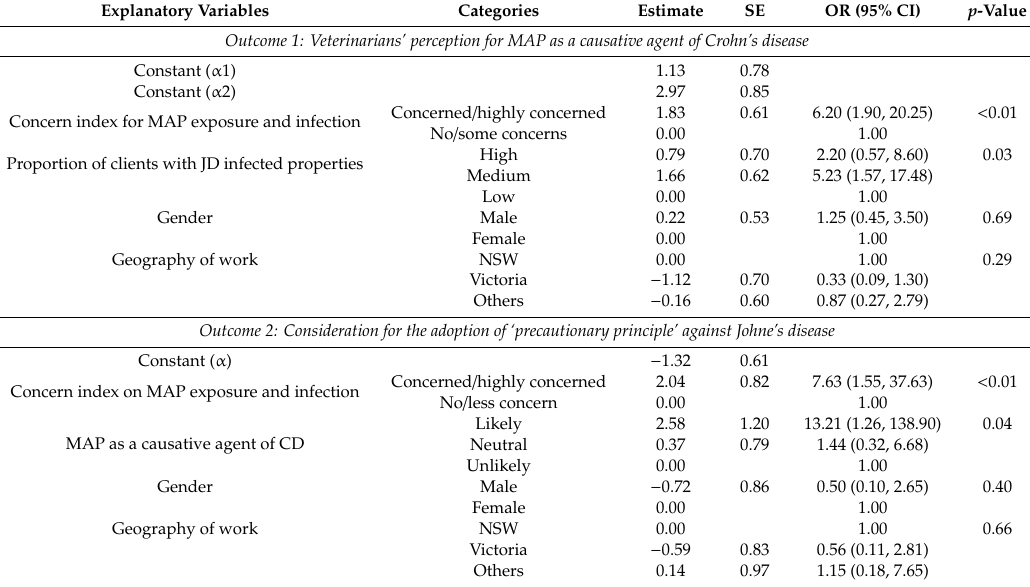
Table 4. Final ordinal logistic regression model for the outcome ‘veterinarians’ perception for MAP as a causative agent of Crohn’s disease, and the final binary logistic regression for the outcome ‘consideration of veterinarians with regards to adoption of ‘precautionary principle’ against Johne’s disease’ based on a study conducted in Australia in